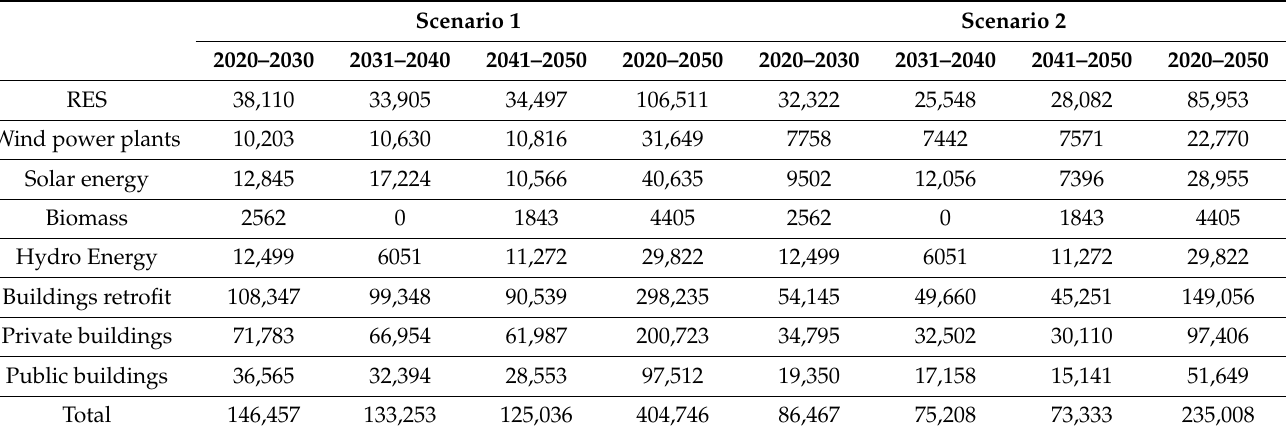
Table 6. Labor requirements of energy